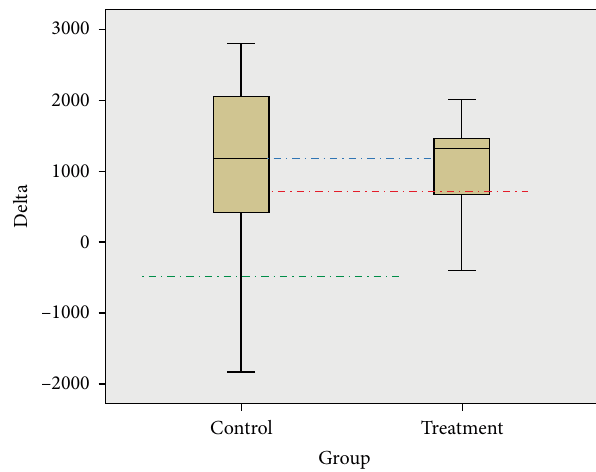
Figure 2: Mean of delta score of IgA level between two